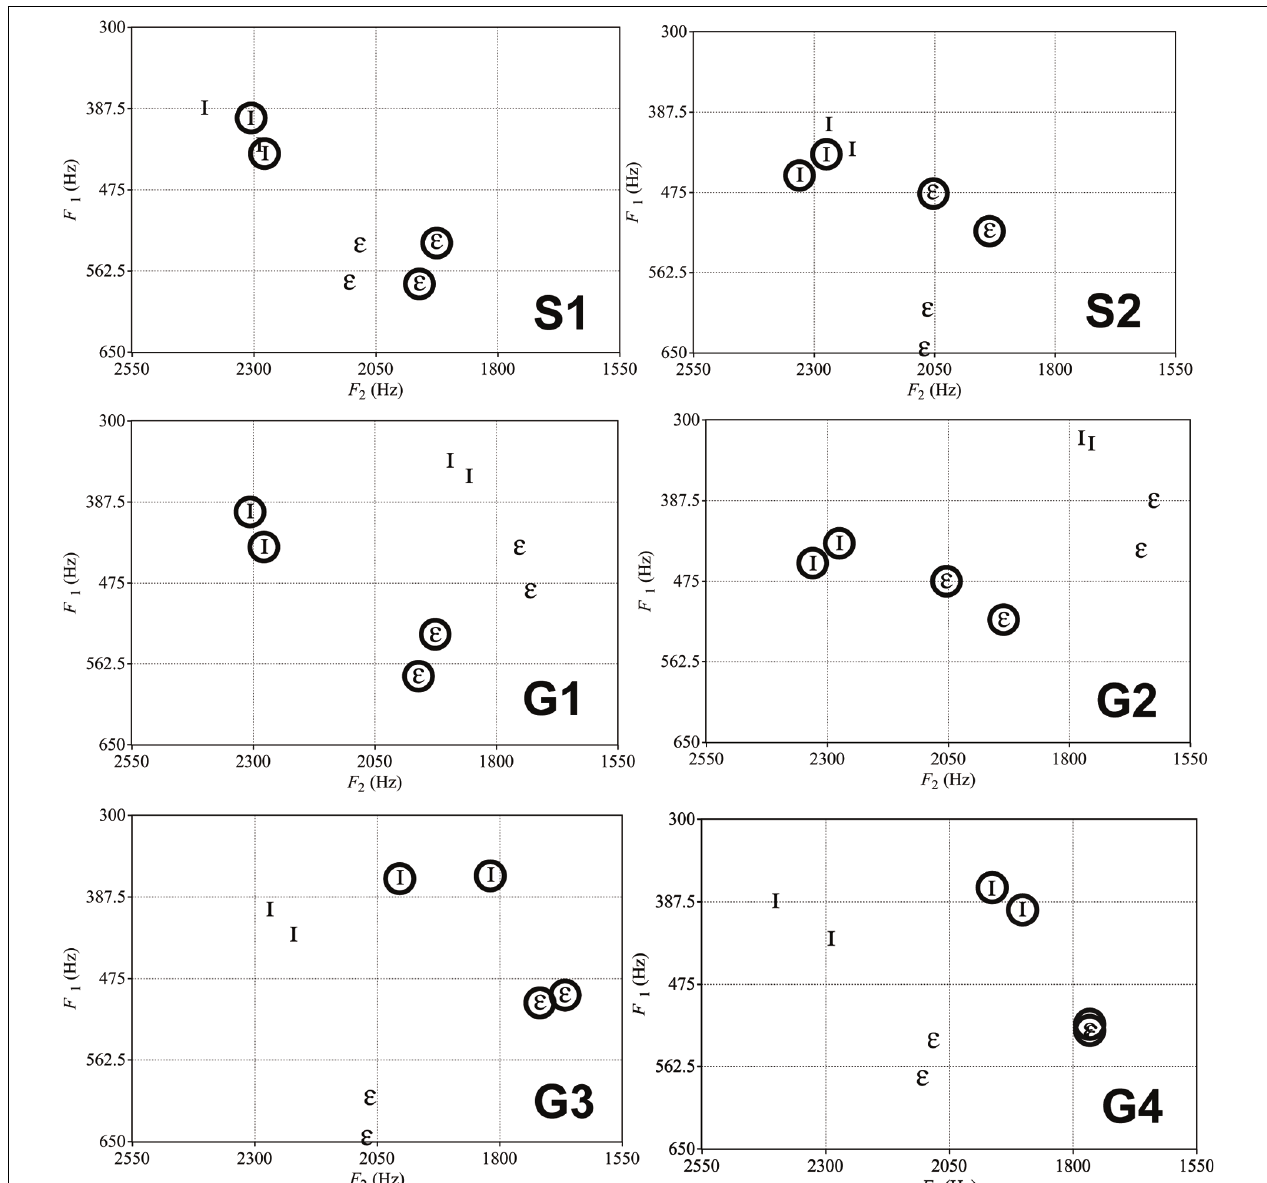
FIGURE 1 | F1 and F2 values for the sets of speakers used for speaker and gender normalization conditions. S1 and S2 show the two stimuli sets used for Speaker normalization (all female tokens). Circled tokens were the FAM Go and No-go tokens used during the training, non-circled ones were the NEW test tokens. G1, G2, G3, and G4 were the stimulus sets used for Gender normalization (male and female tokens). In sets G1 and G2, the FAM Go and